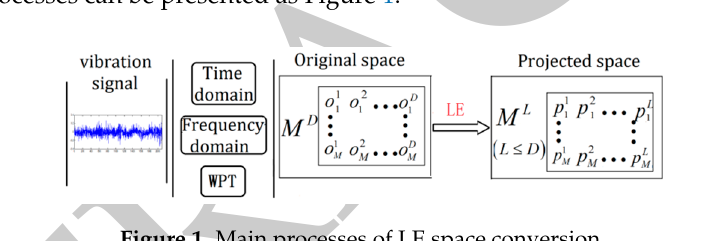
Figure 1. Main processes of LE space conversion.